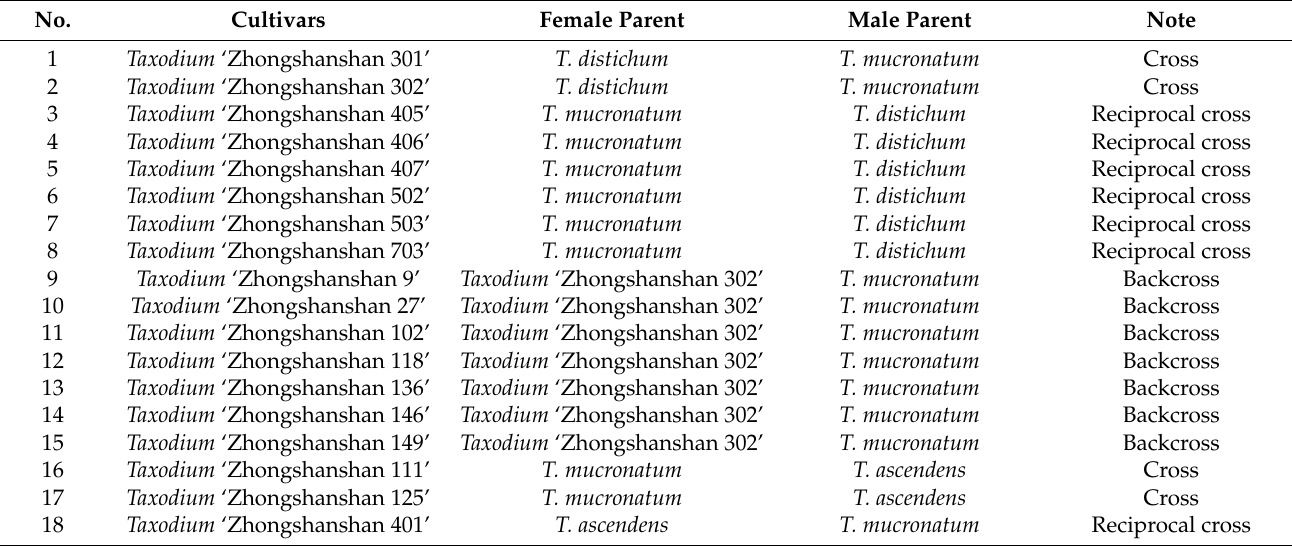
Table 1. Sample information of T. ascendens , T. distichum , T. mucronatum , and eighteen of their hybrid progenies used in this